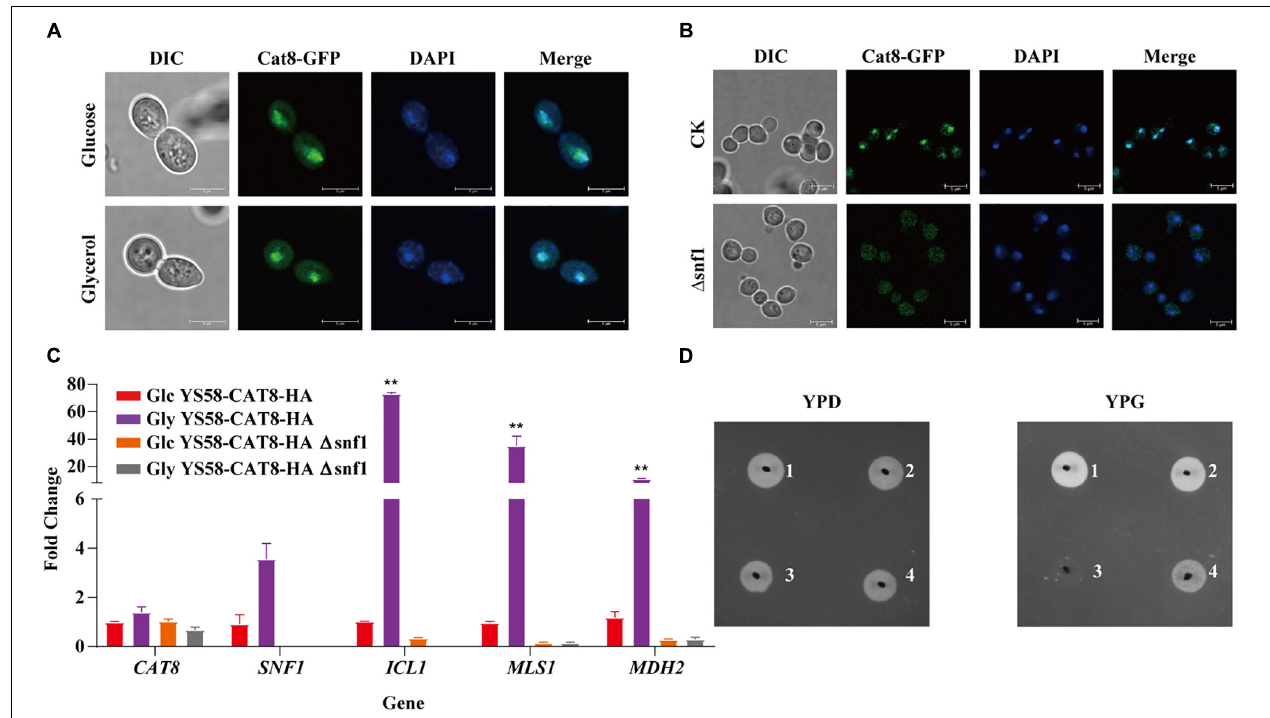
FIGURE 2 | Cat8 intracellular localization and transcriptional regulatory activity in response to different carbon sources. (A) Cat8 intracellular localization under glucose or glycerol condition. (B) Effect of Snf1 on Cat8 subcellular localization under glycerol condition. For (A,B) , the white bar represents 5 µ m. (C) Transcriptional levels of genes CAT8 , SNF1 , ICL1 , MLS1 , and MDH2 normalized to ACT1 . (D) Growth assay to indicate the effect of Snf1 deletion and Cat8 overexpression, YS58-HA (1), YS58-CAT8-HA (2), YS58-HA (cid:49) snf1 (3), and YS58-CAT8-HA (cid:49) snf1 (4). Data shown are mean values ± SDs of triplicates. Statistical difference was determined by two-tailed Student’s t -test, ** p <